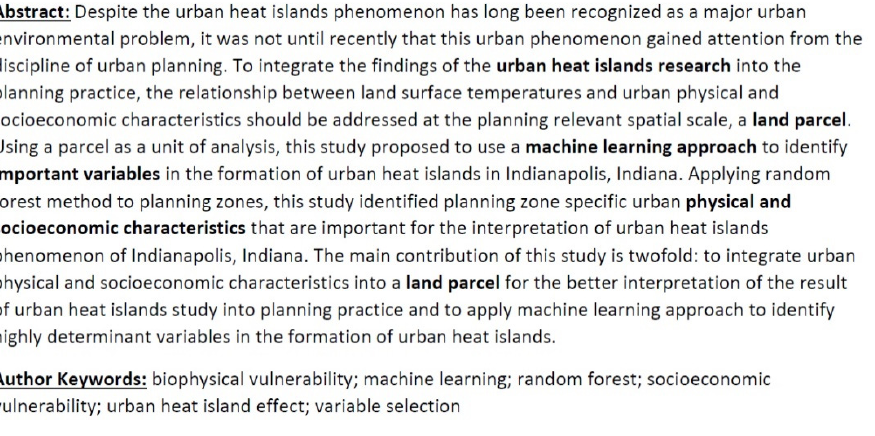
Figure 4. An example of an article abstract [55] highlights our extracted keywords in the text and lists the author-assigned keywords under the text.